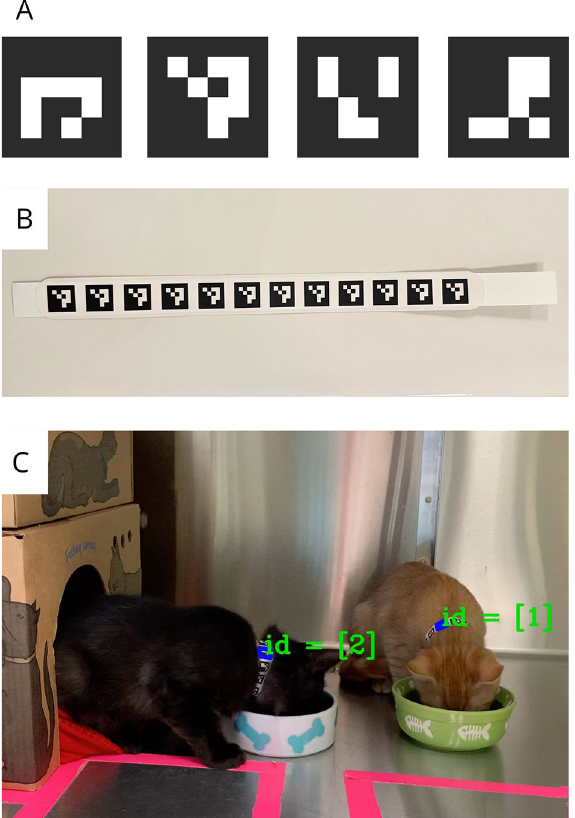
Figure 2. ( A ) Examples of individual 16-bit ArUco markers of unique markers for individual identification numbers of 0, 1, 2 and 3. ( B ) TabBand paper veterinary ID collar with a custom sticker, including repeating ID marker. ( C ) Two cats with unique collar markers. Detection of each ID is visible in annotated output as indicated by “id = [1]” and “id = [2]”, showing individual cat IDs detected in the